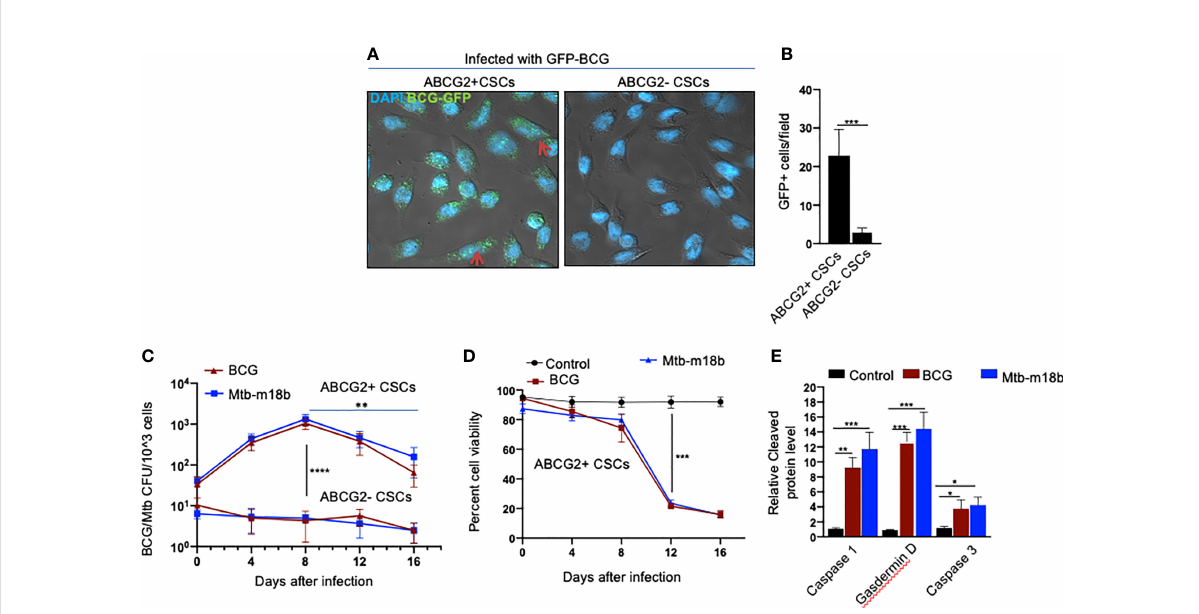
FIGURE 2 BCG replicates intracellular to EpCAM+/ABCG2+ CSCs of SCC-25 cell line and induces pyroptosis. Post hypoxia/reoxygenation treated EpCAM +/ABCG2+ CSCs (henceforth known as EpCAM+/ABCG2+ CSCs) obtained from SCC-25 cells exposed to the in vitro system of hypoxia and reoxygenation (5) is sensitive to BCG-induced cell death. (A) Confocal microscopy images (magni fi cation, 20×) showing the localization of GFP- positive BCG intracellular to EpCAM+/ABCG2+ CSCs (shown with arrows) versus post hypoxia/reoxygenation treated EpCAM+/ABCG2- CSCs (henceforth known as EpCAM+/ABCG2- CSCs). (B) Histogram shows 20-fold increase in GFP-positive BCG per hundred microscopic fi eld in EpCAM+/ABCG2+ CSCs versus EpCAM+/ABCG2- CSCs. (C) Intracellular BCG/Mtb-m18b-CFU in EpCAM+/ABCG2+ CSCs versus EpCAM +/ABCG2- CSCs after infection. (D) Trypan blue assay of cell viability of BCG/Mtb-m18b – infected EpCAM+/ABCG2+ CSCs after infection. (E) ELISA-based measurement of cleaved caspase-1, gasdermin D, and caspase-3 levels in EpCAM+/ABCG2+ CSCs of day 12 after BCG/Mtb- m18binfection. Data represent means ± SEM (B – D) . N = 3 independent experiments; *p < 0.05, **p < 0.01, ***p < 0.001, and ****p < 0.0001 ( B – D : Student ’ s t-test; E: one-way ANOVA with Dunnet post hoc